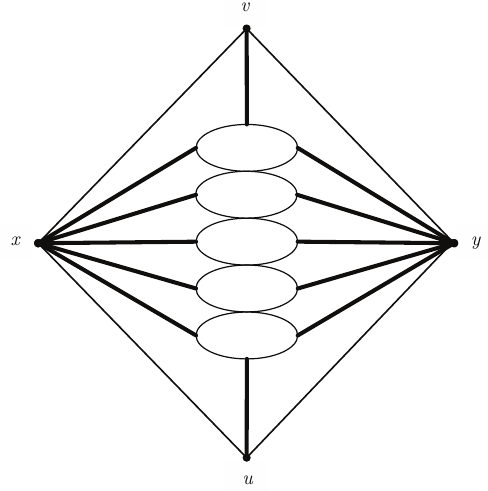
Figure 5. The general structure of a near-triangulation G xy